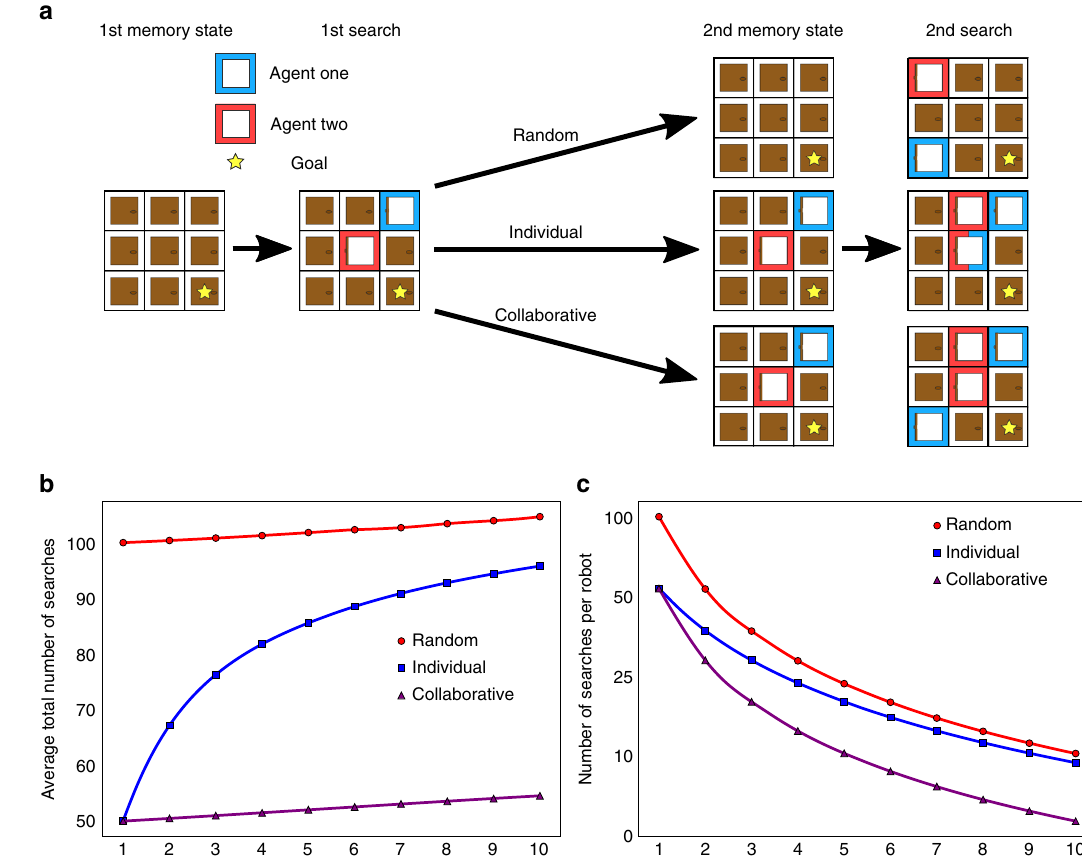
Fig. 2 Agent-based simulations. a Scheme of the simulated search with the three different strategies. b Average number of searches needed under each strategy as a function of the number of robots. c Search ef fi ciency in terms of the total number of searches that are needed on